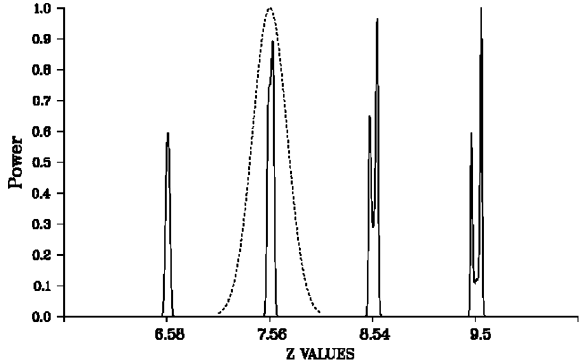
FIG. 8. Pulse shape of the fundamental harmonic at different positions inside the undulator, 1 : 0 ¼ 3 : 39 (cid:2) 10 1 ; same parame- ters as in Fig. 6.